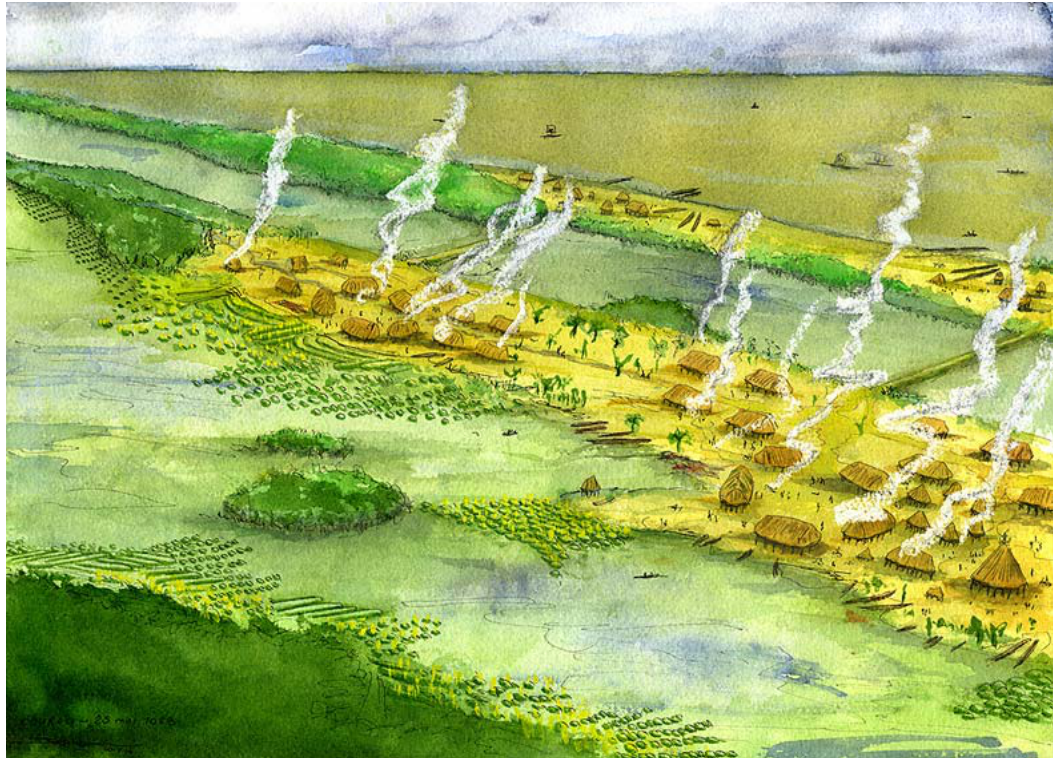
Figure 16. Reconstitution of the pre-Columbian landscape near